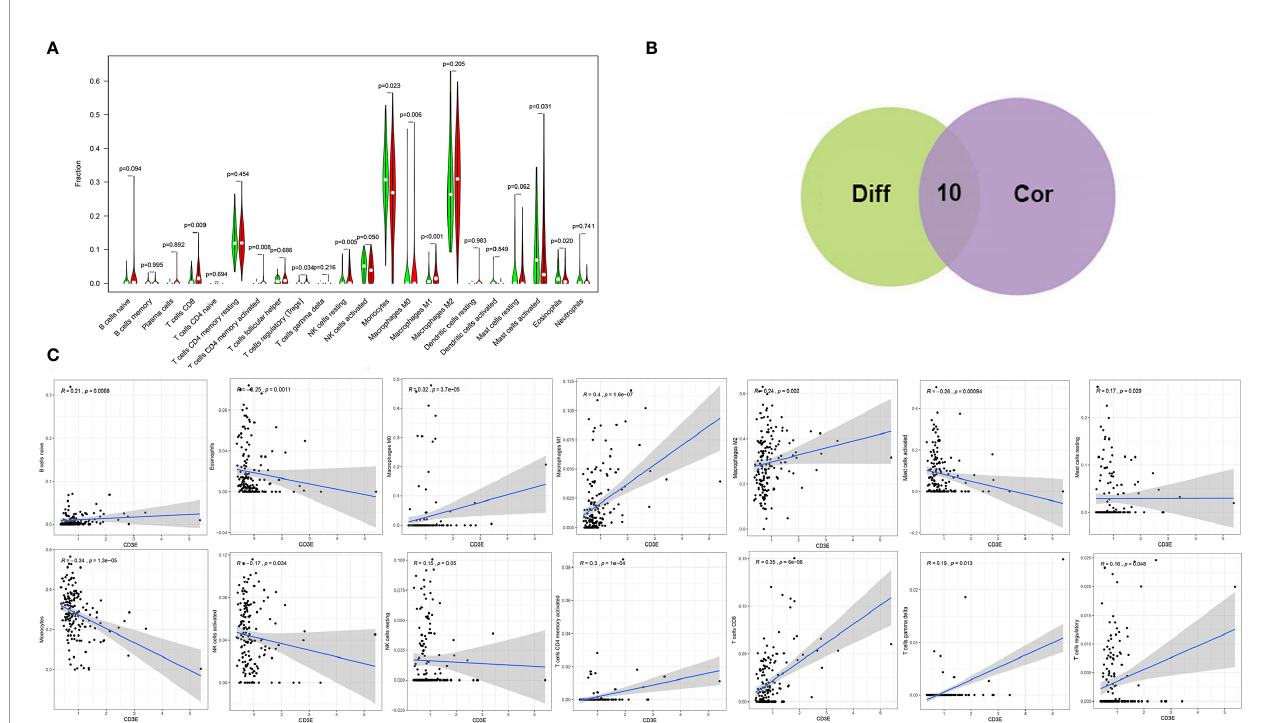
FIGURE 10 | Correlation of TICs proportion with CD3E expression. (A) Violin plot showed the ratio differentiation of 22 kinds of immune cells between LGG tumor samples with low or high CD3E expression relative to the median of CD3E expression level, and Wilcoxon rank sum was used for the signi fi cance test. (B) Venn plot displayed ten kinds of TICs correlated with CD3E expression codetermined by difference and correlation tests displayed in violin and scatter plots, respectively. (C) Scatter plot showed the correlation of 14 kinds of TICs proportion with the CD3E expression ( P < 0.05). The red line in each plot was fi tted linear model indicating the proportion tropism of the immune cell along with CD3E expression, and Pearson coef fi cient was used for the correlation